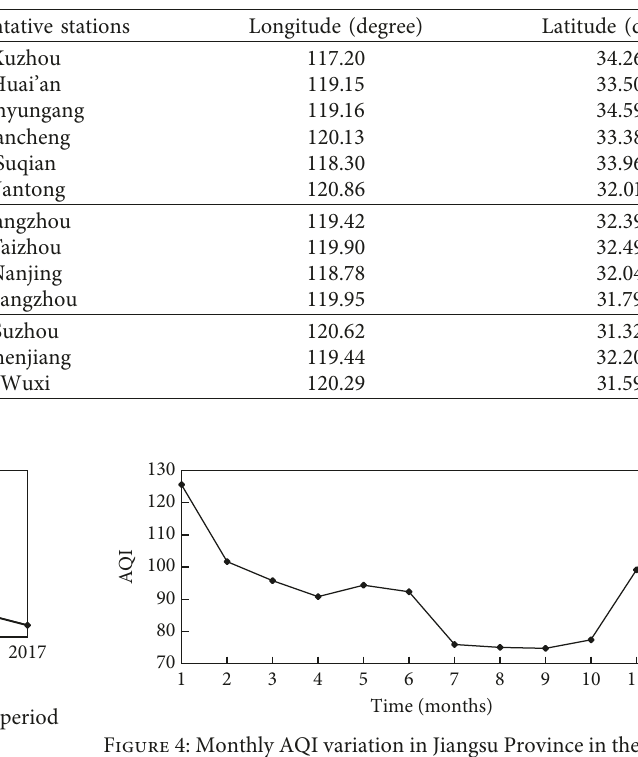
Table 1: The letters and their corresponding city names in central Jiangsu, northern Jiangsu, and southern